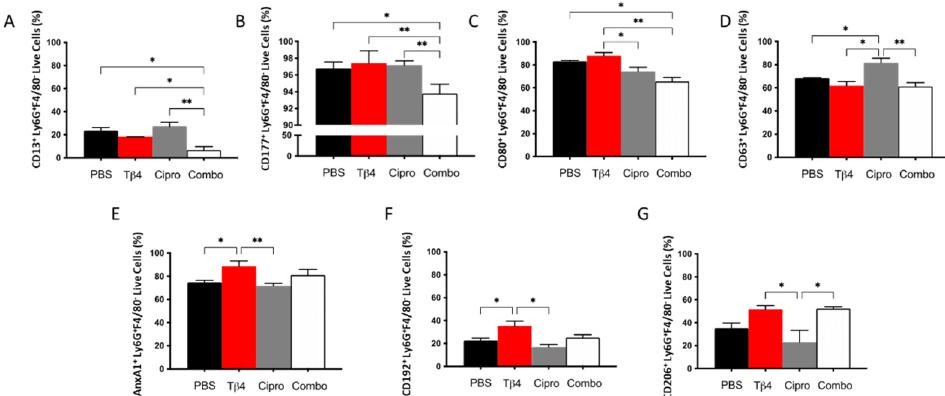
Figure 2. Expression of cell surface markers as detected on PMNs by flow cytometry. Select proin- flammatory molecules CD13 ( A ), CD177 ( B ), CD80 ( C ), and CD63 ( D ) and anti-inflammatory mole- cules AnxA1 ( E ), CD192 ( F ), and CD206 ( G ) were detected on CD45 + Ly6G + F4/80 - PMNs from 3 day- infected corneas of PBS-, T β 4-, cipro-, and adjunct-treated B6 mice. Results are shown as averages of singlet populations for CD45 + Ly6G + F4/80 - PMNs. n = 5 corneas/group; * p < 0.05, ** p < 0.01.